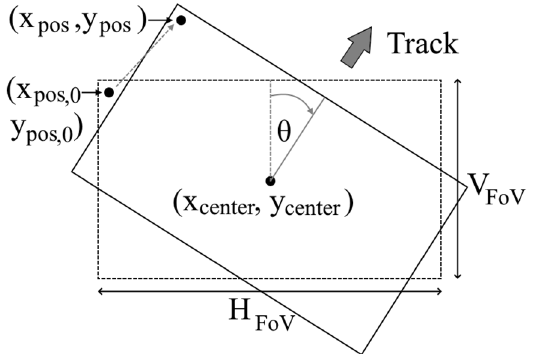
Figure 4. The initial pixel position assignment (x pos,0 , y pos,0 ), shown in the dashed-line box. The post-rotation position (x pos , y pos ) is shown in the solid-line box. H FoV and V FoV are the horizontal and vertical dimensions.